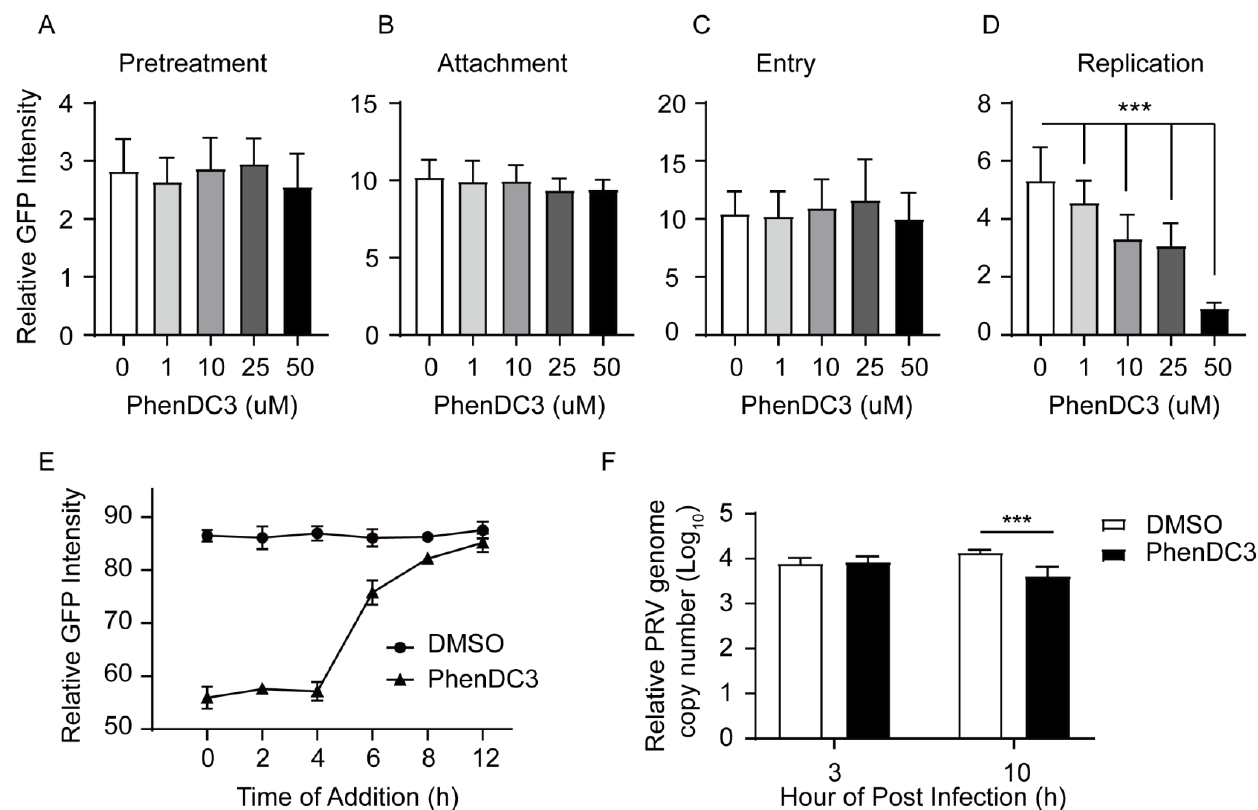
Figure 4. Compound PhenDC3 inhibited PRV DNA replication in PK-15 cells. ( A ) For the pretreatment assay, PK-15